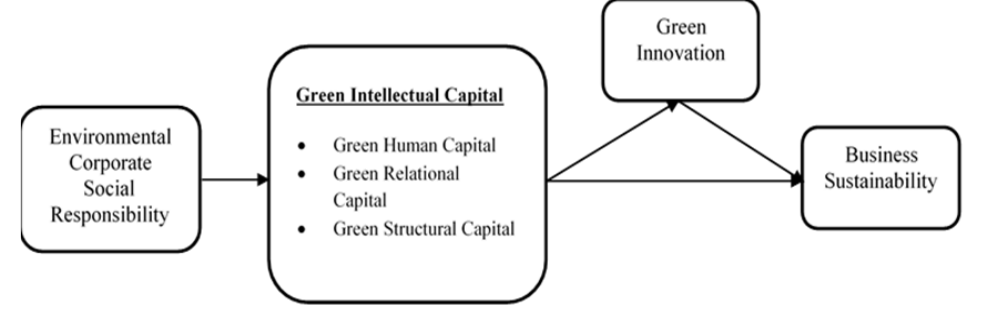
Figure 1. Conceptual Model .